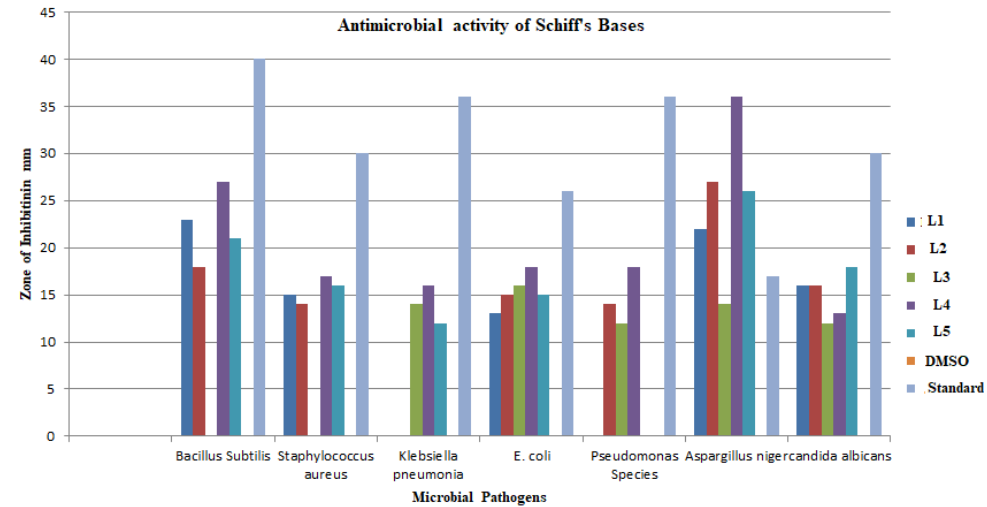
Figure 4. Graphical representation of antibacterial and antifungal activities of Schiff bases against bacterial and fungal pathogens.